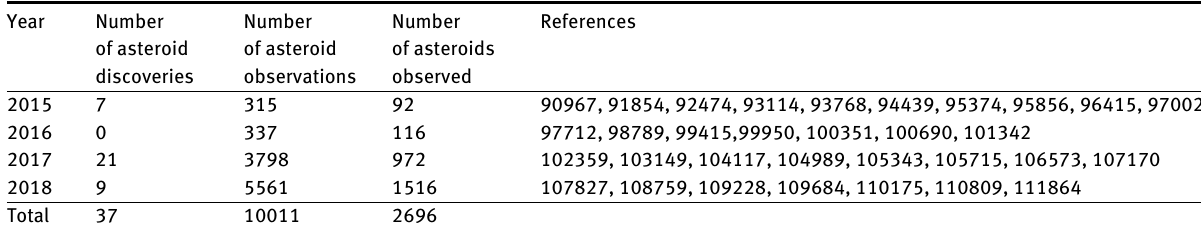
Table 2. Statistics of asteroid discoveries and astrometric observations of the asteroids (both new and known) at the Baldone Observatory in